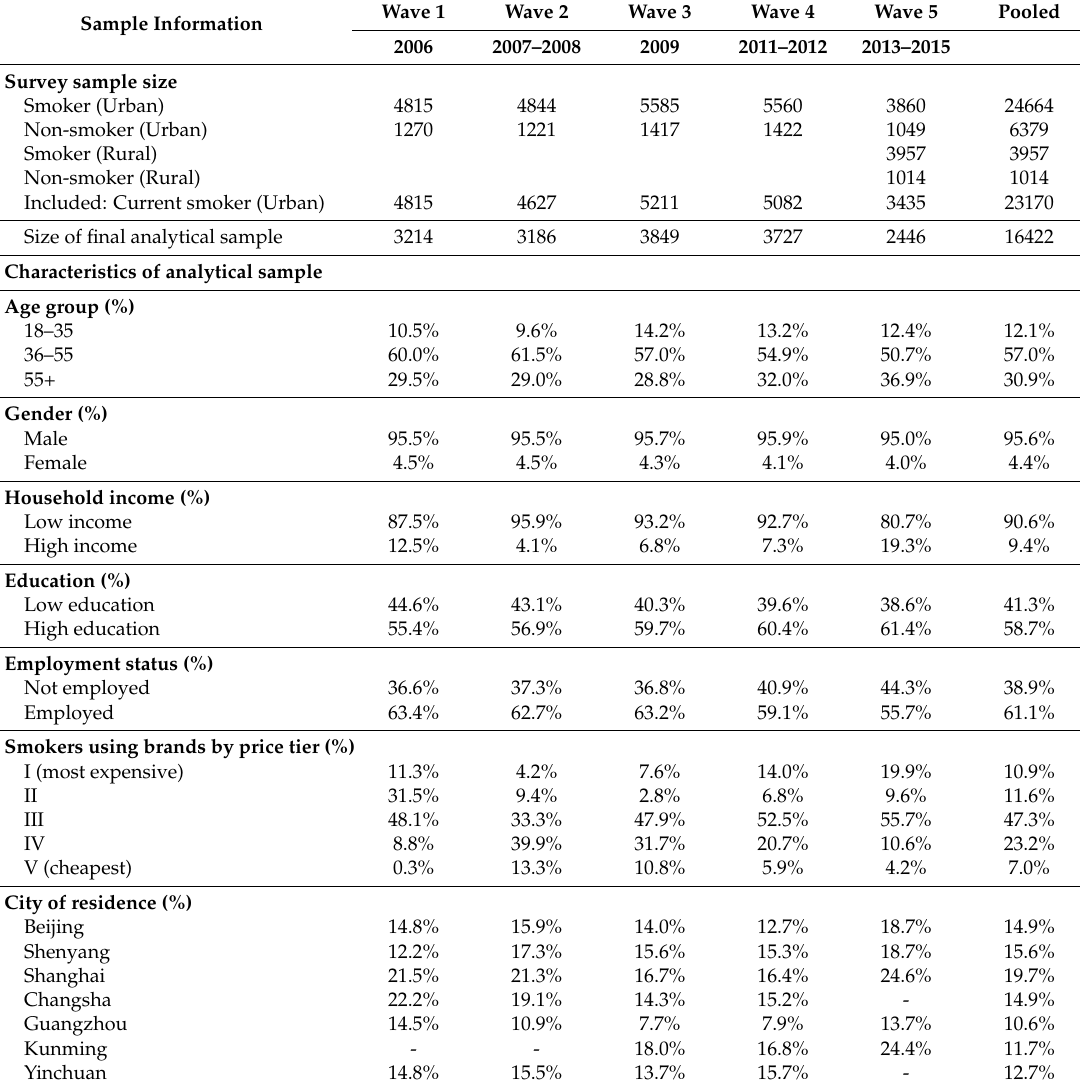
Table 2. Summary of sample selection and characteristics of the analytical